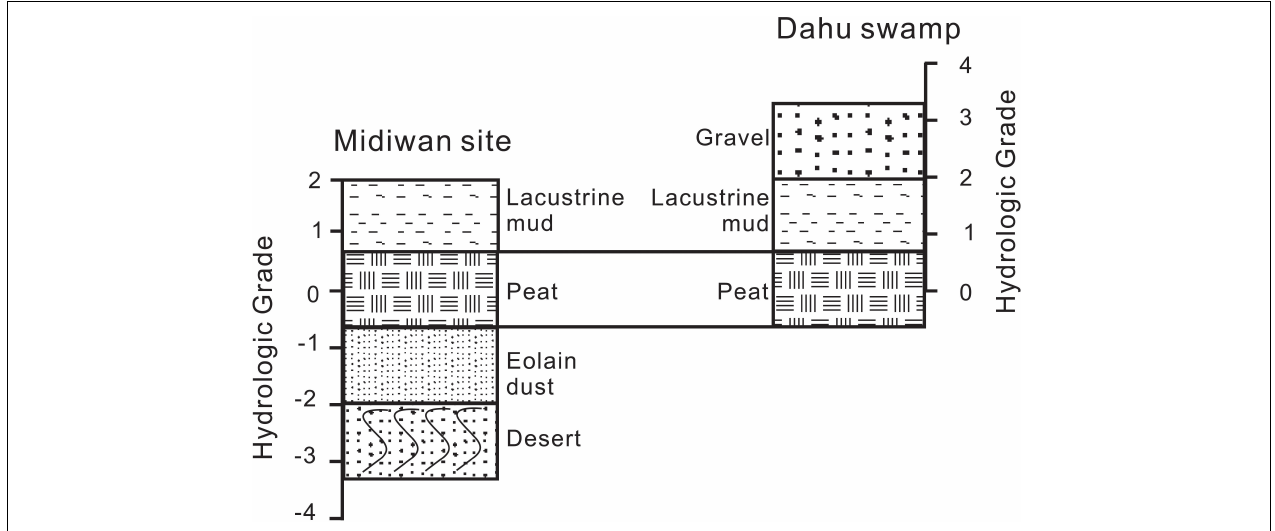
FIGURE 5 | Relationship between the hydrologic grade and the depositional facies in Midiwan and Dahu. Axes beside the facies show the hydrologic grades of the corresponding facies. The order of each facies in this map does not represent the sequences in these sections.